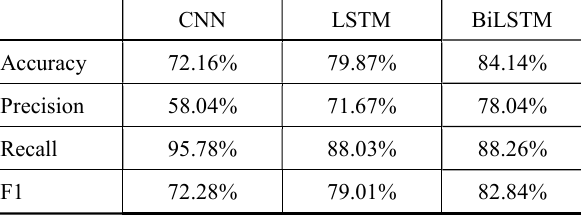
Table 1: Performance Metrics of the tested classifiers